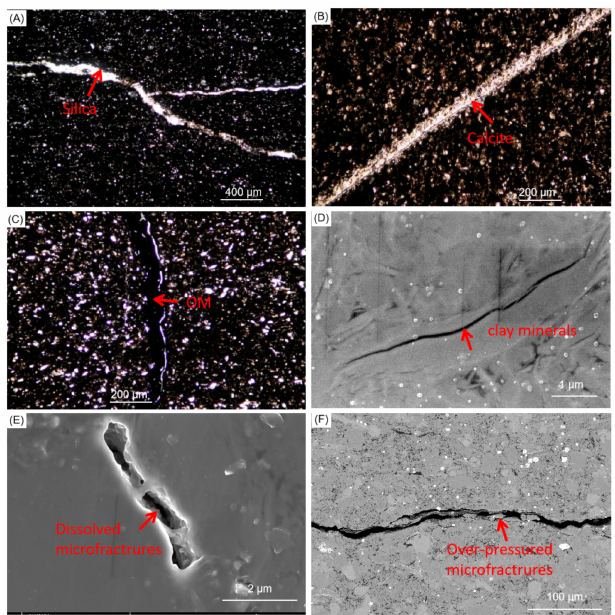
Figure 10. Backscattered electron and microscopy images showing fractures and microfractures in various depositional structures. ( A ) Fractures are filled with silica, sample number: WX-1; ( B ) Fractures are filled with calcite, sample number: WX-2; ( C ) Fractures are filled with OM, sample number: WX-3; ( D ) Shrinkage microfractures propagate from among clay mineral grains, sample number: 4-16-1; ( E ) Dissolved microfractures propagate from between carbonate mineral grains, sam- ple number: 6-22-1; ( F ) Over-pressured microfractures propagate from along OM-mineral interfaces, sample number: